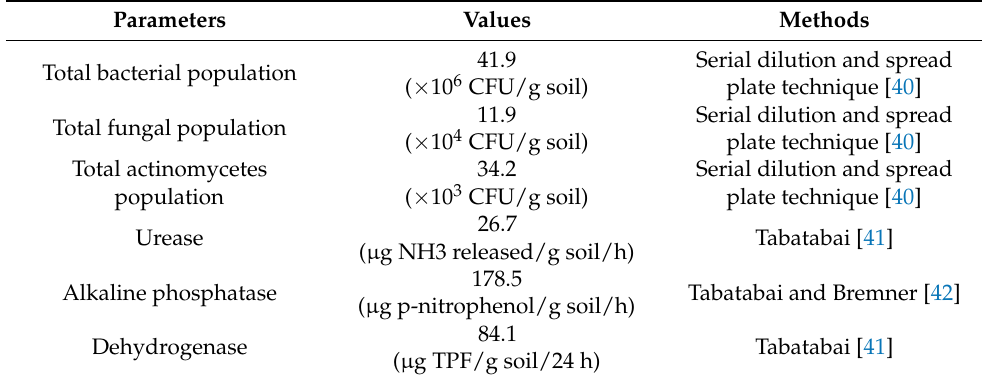
Table 3. Initial microbiological properties of experimental